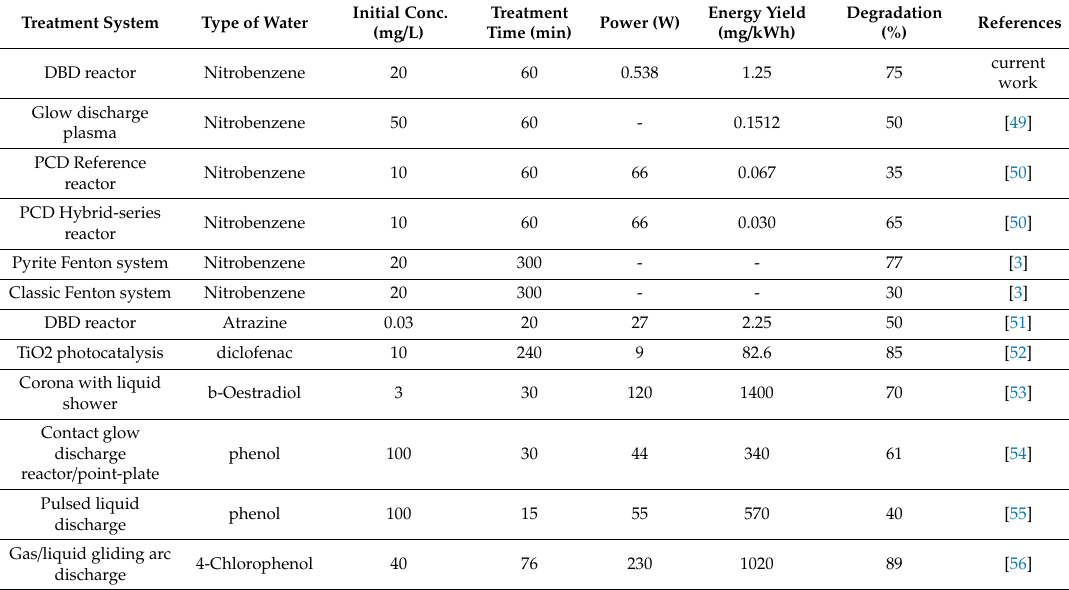
Figure 11. ( a ) The Charge-Voltage (Q-V) waveform and ( b ) Lissajous curve at 1.8 kV and 50 Hz. Table 3. The comparison of the DBD system with other AOPs for power, energy yield and degradation efficiency.